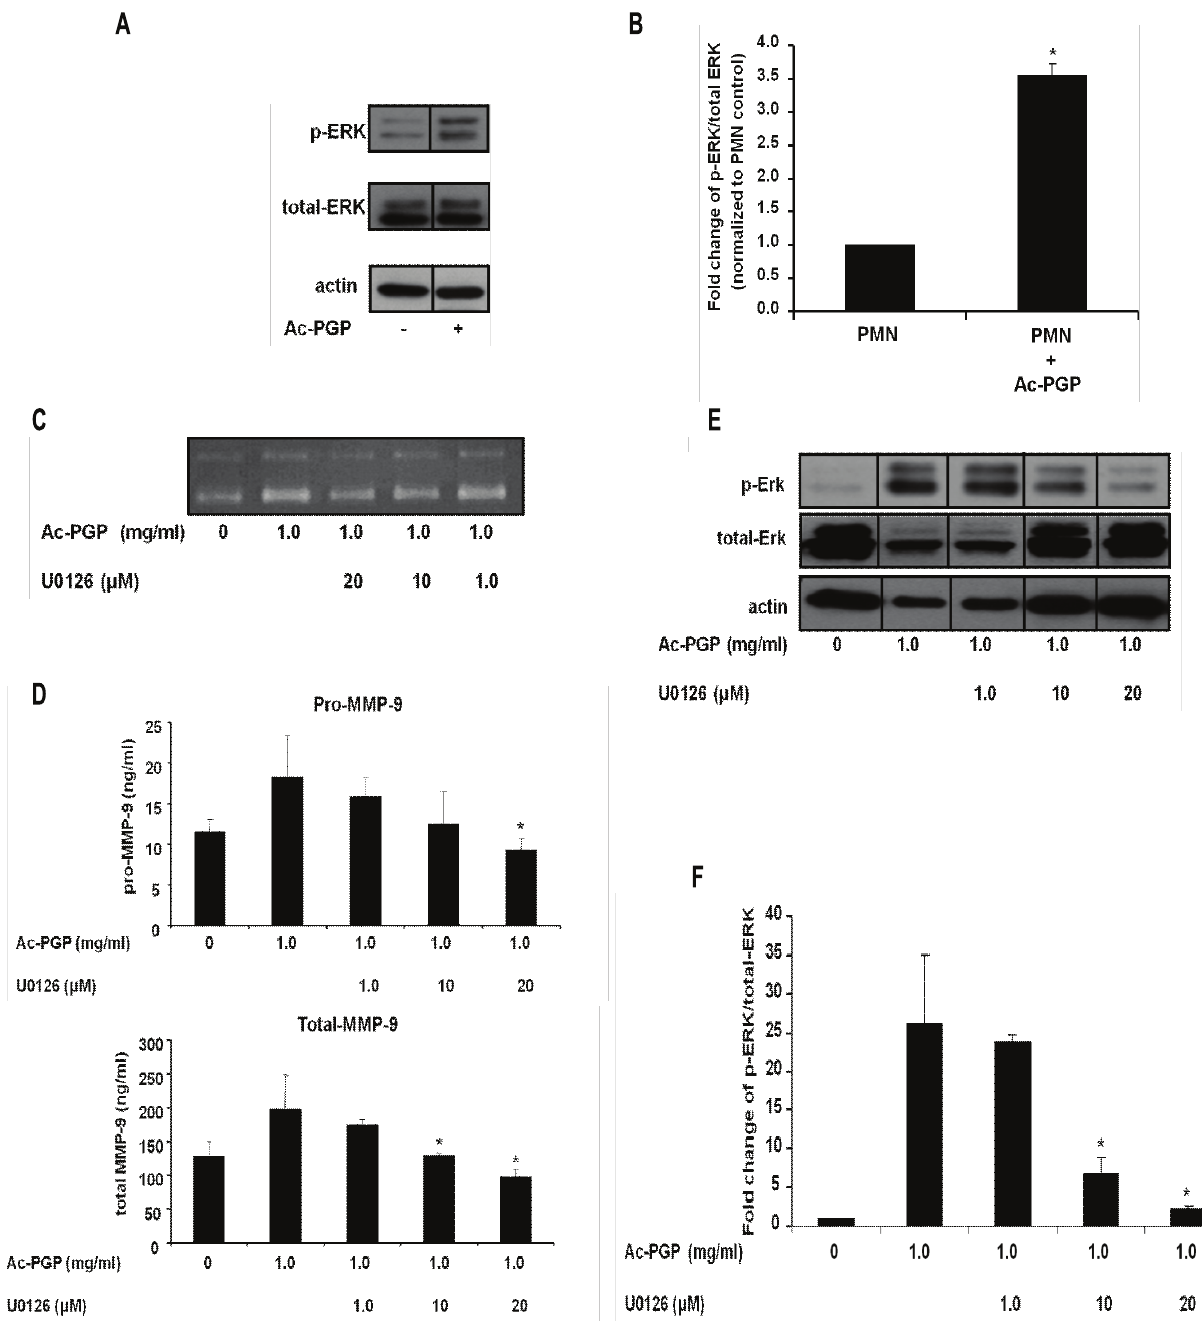
Figure 2. The effect of ERK1/2 MAPK inhibitor on the Ac-PGP mediated MMP-9 release in PMNs. PMNs were pretreated with ERK1/2 MAPK inhibitor U0126 or vehicle for 30 minutes, and then stimulated with Ac-PGP (1.0 mg/ml) for 30 minutes. Cell-free supernatants were collected for MMP-9 assay. The levels of ERK1/2 MAPK were determined by western blot analysis of lysates from stimulated PMNs with actin controls which paralleled total ERK 1/2. Phosphorylated ERK was determined using an anti-ERK antibody that recognizes phosphorylated threonine and tyrosine residues (Thr202/Tyr204). A . Total and phosphorylated level of ERK1/2 MAPK representative of three gels. B . Fold change of phosphorylation of ERK1/ 2 MAPK versus total ERK1/2 MAPK normalized to PMN control. C . The detection of gelatinolytic activity by g elatin zymography representative of three gels. D . The quantification of specific MMP-9 activity by ELISA-based assay. E . Total and phosphorylated level of ERK1/2 MAPK representative of three gels. F . Fold change of phosphorylation of ERK1/2 MAPK versus total ERK1/2 MAPK normalized to PMN control. *p , 0.05 compared to Ac-PGP without inhibitor pretreatment.